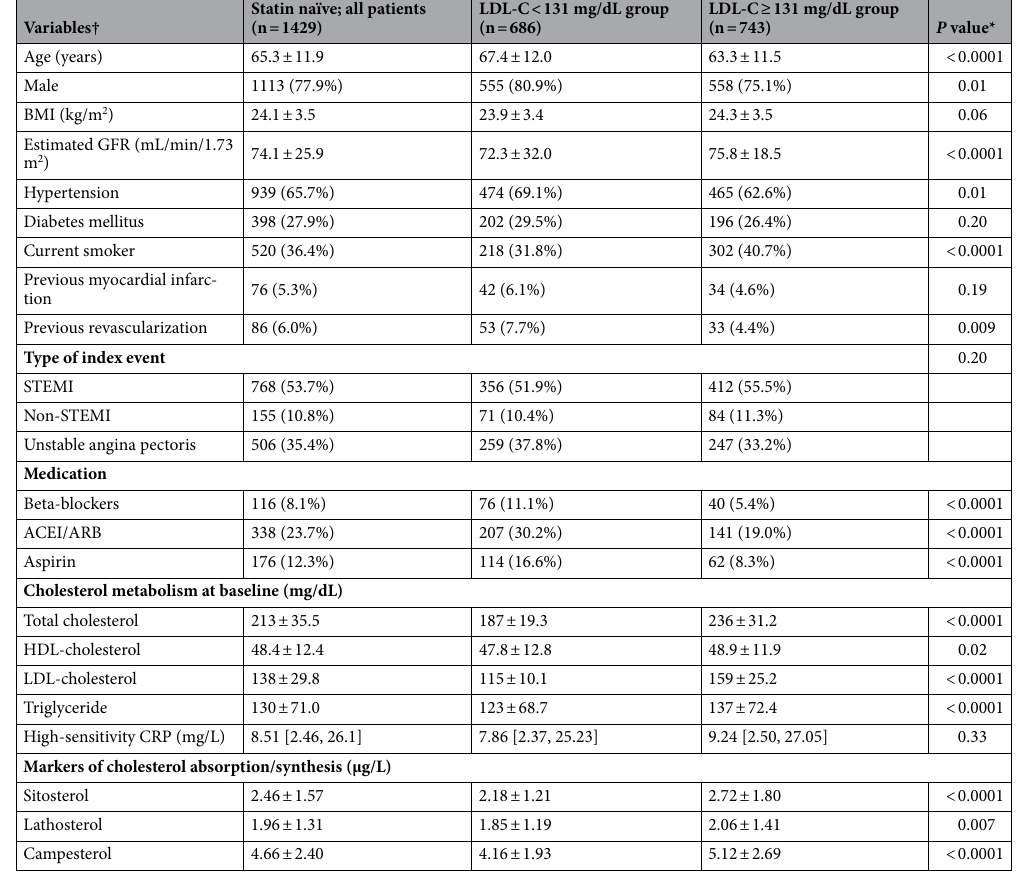
Table 1. Baseline characteristics of the study population. *P value refers to comparison between low LDL-C group and high LDL-C group. Abbreviations: BMI, body mass index; GFR, glomerular filtration rate; STEMI, ST-elevation myocardial infarction; ACEI, angiotensin-converting enzyme inhibitors; ARB, angiotensin II receptor blockers; HDL, high-density lipoprotein; LDL-C, low-density lipoprotein cholesterol; CRP, C-reactive protein. † Data are expressed as mean ± standard deviation, median [interquartile range], or as number (percentage).